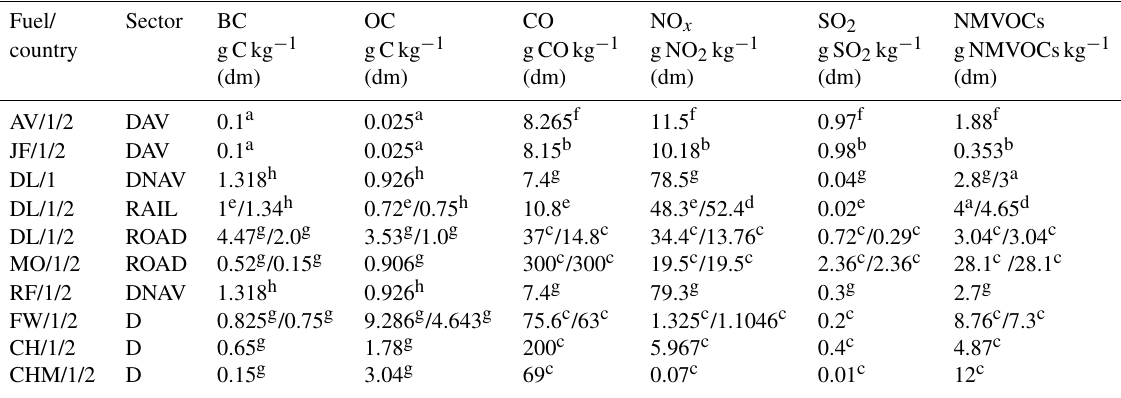
Table 1. BC, OC, CO, NO x , SO 2 and NMVOCs EFs for the main anthropogenic sources, for different fuels (AV: aviation gasoline, JF: jet fuel, DL: diesel, MO: motor gasoline, RF: residual fuel oil, FW: wood, CH: charcoal, and CHM: charcoal making), type of country (1: semi-developed, 2: developing) and activities sectors (DAV: domestic aviation, DNAV: domestic navigation, RAIL: rail traffic, ROAD: road traffic, and D: residential